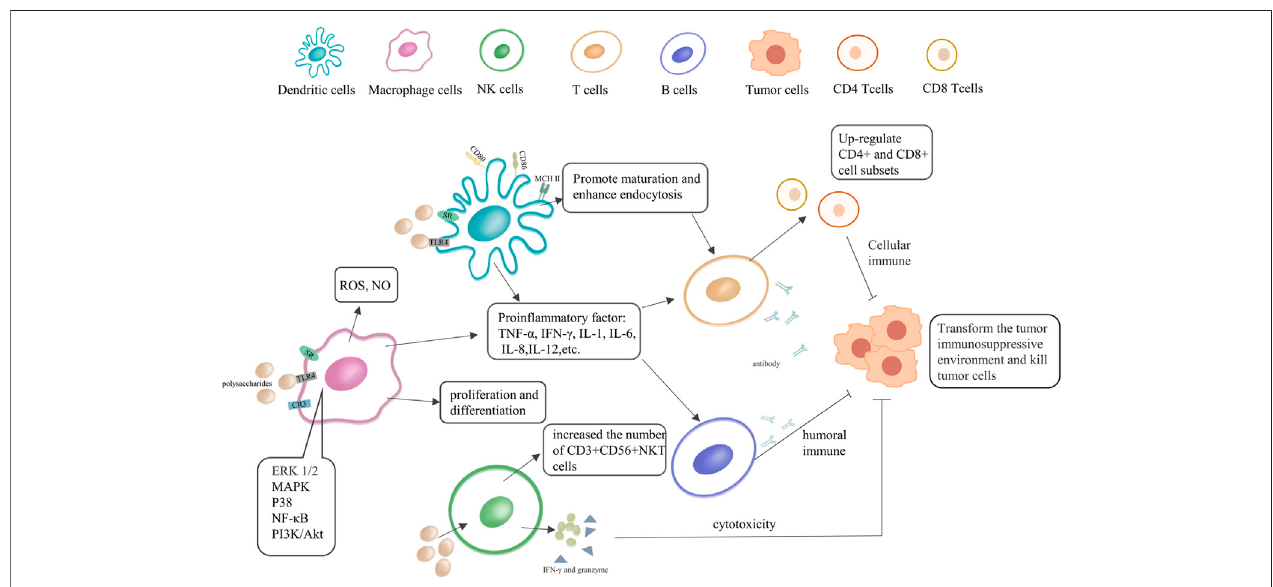
FIGURE 2 | The immunoregulatory effect of natural polysaccharides in immune cells. Polysaccharides can directly or indirectly activate dendritic cells (DCs), NK, macrophages, T and B lymphocytes, immune cells. They can also produce antibodies, secrete immune factors, and promote immune activation pathways.